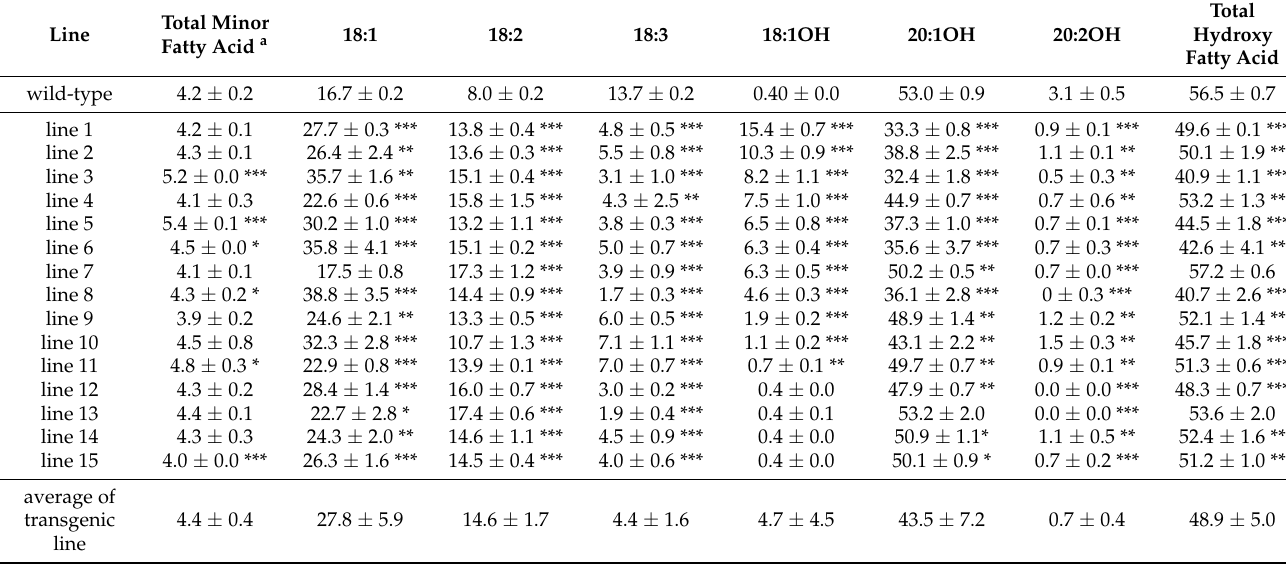
Table 2. Fatty acid composition (mole %) in T1 seeds expressing CsFAD2 RNAi + AtFAD3 RNAi + CsFAE1